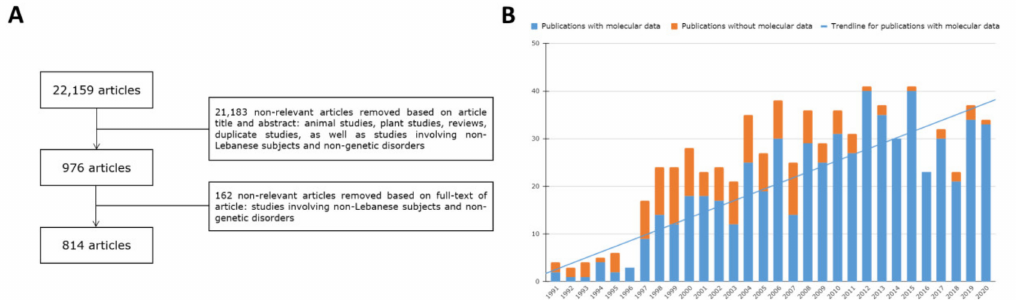
Figure 1. Bibliographic review of papers with Lebanese subjects. ( A ) Flowchart detailing criteria of study selection ( B ) Number of final selected publications (1991–2020) with and without molecular data classed by year of publication. Trendline is based on the number of molecular studies per